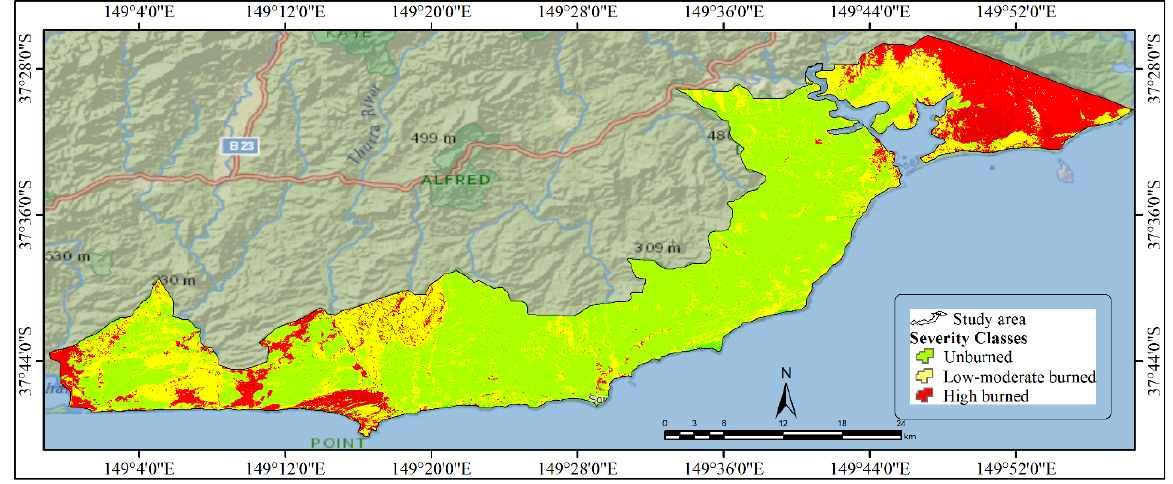
Figure 4. The relationship between RBR and intensity levels under various environmental conditions for VH polarization ( a ), VV polarization ( b ), and NDBI ( c ). Median values (horizontal line), percentiles (25% and 75%, box edges), non-outlier values range (whiskers), and outlier values (circles) are seen in box plots.